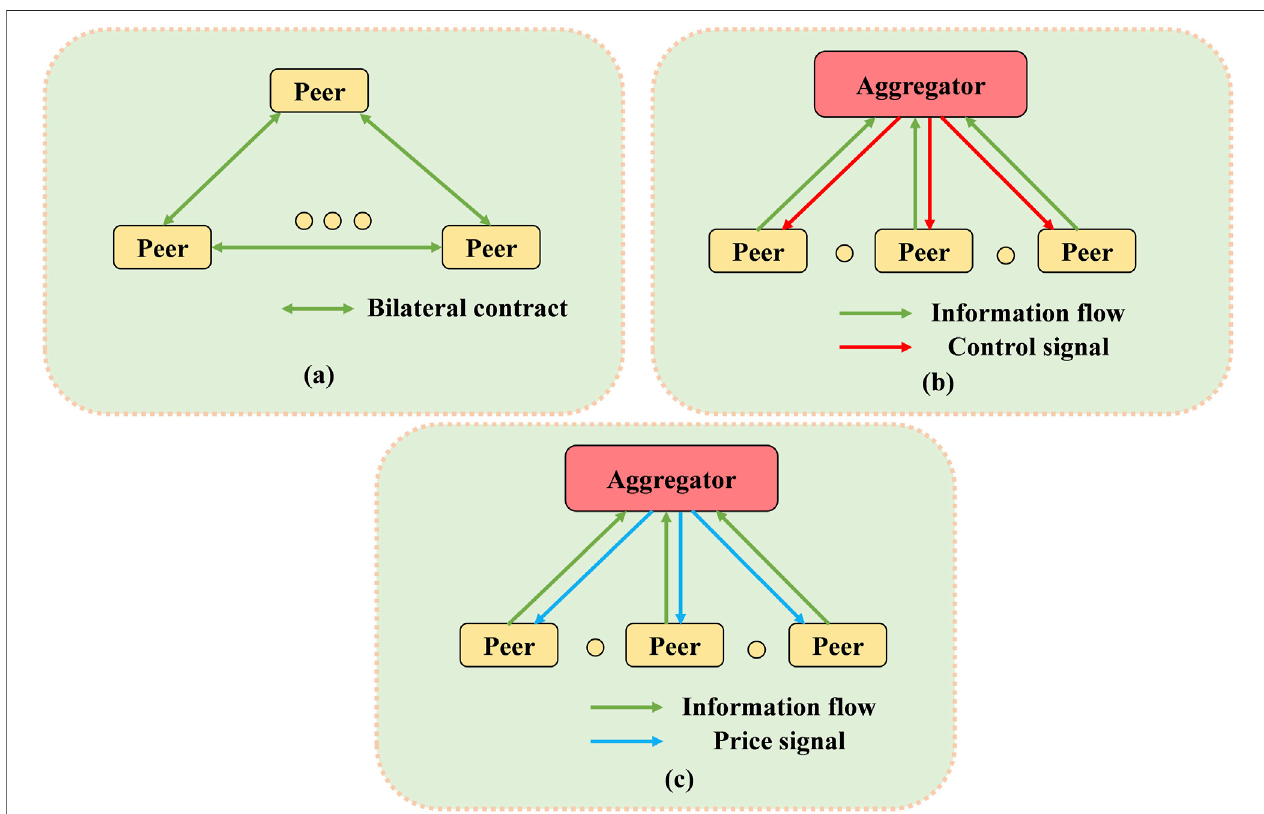
FIGURE 1 | Three types of P2P market architecture: (A) decentralized market; (B) centralized market; (C) hybrid market.